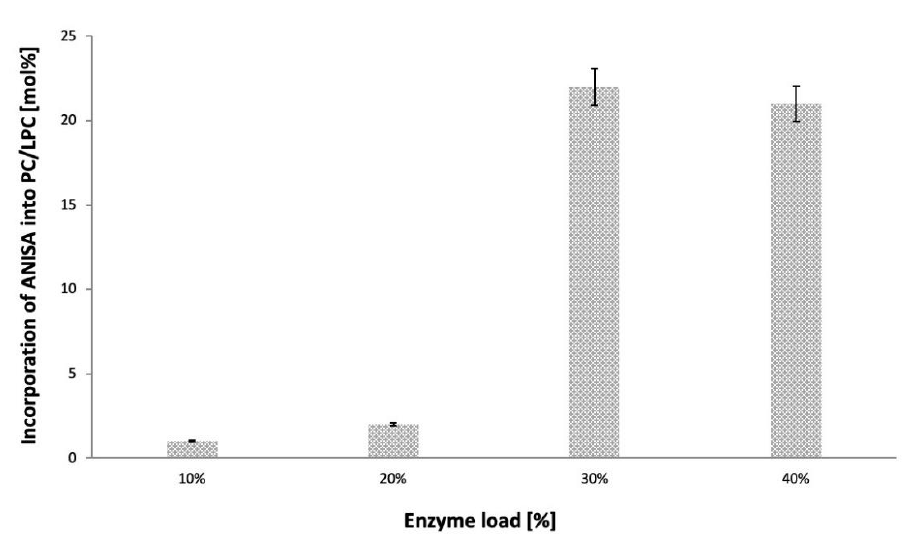
Figure 5. E ff ect of di ff erent lipase dosages on the incorporation of ANISA into egg-yolk PC in the acidolysis reaction (reaction conditions: 1:15 PC / ANISA molar ratio, solvent: toluene:chloroform (9:1 v / v ) Figure 5. Effect of different lipase dosages on the incorporation of ANISA into egg-yolk PC in the 2 mL, enzyme load 30% ( w / w ) Novozyme 435, temperature 50 ◦ C, reaction time 72 h). Vertical bars acidolysis reaction (reaction conditions: 1:15 PC/ANISA molar ratio, solvent: toluene:chloroform (9:1 represent SD, n = v/v) 2 mL, enzyme load 30% (w/w) Novozyme 435, temperature 50 °C, reaction time 72 h). Vertical bars represent SD, n = 3.